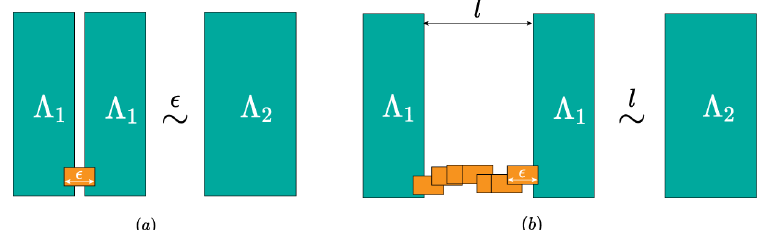
Figure 5: (a) Illustration of ε − topology: Λ by a patch of diameter ε , see Eq. (39). (b) Illustration of l − topology: in this case a combination of many ε − patches is necessary to make Λ Λ 2